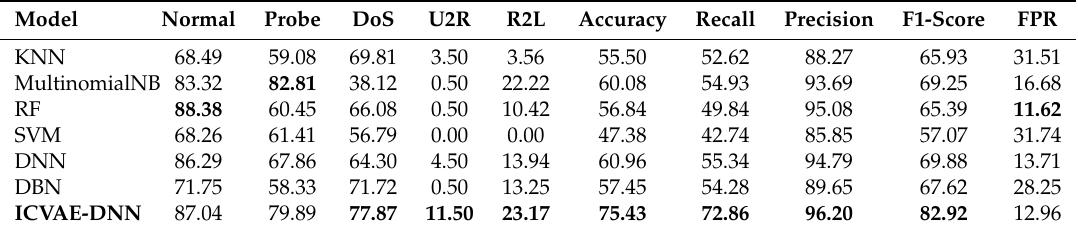
Table 10. Comparison of detection performance for different classification methods on the NSL-KDD (KDDTest-21) dataset